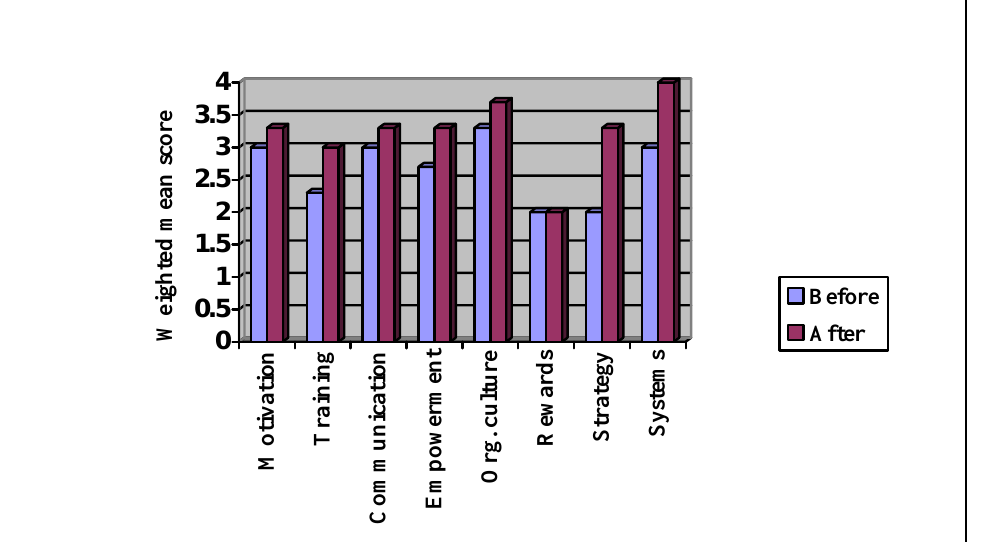
Figure 1.2 The results of front line employees’ evaluation of the components of the service triangle (before and after